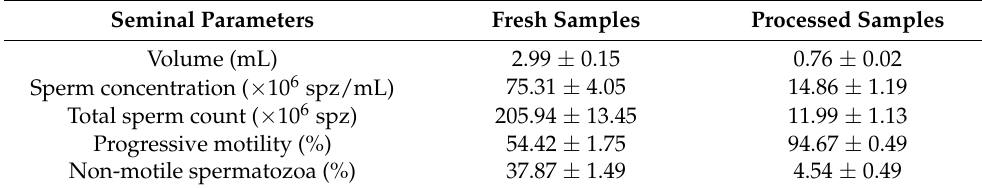
Table 1. Seminal characteristics of fresh semen samples and after preparation for in vitro fertiliza- tion